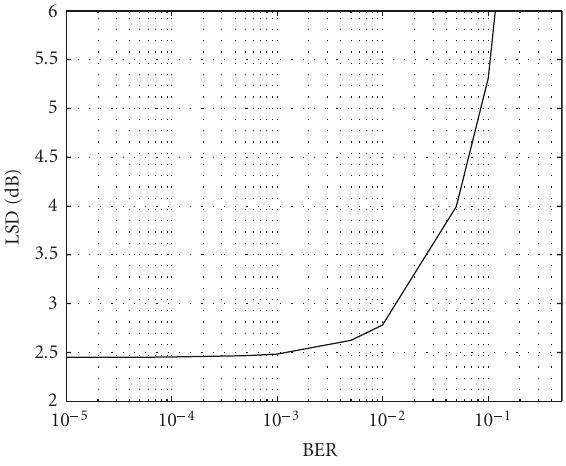
Figure 9: E ff ect of BER in side information on the SBE LSD.